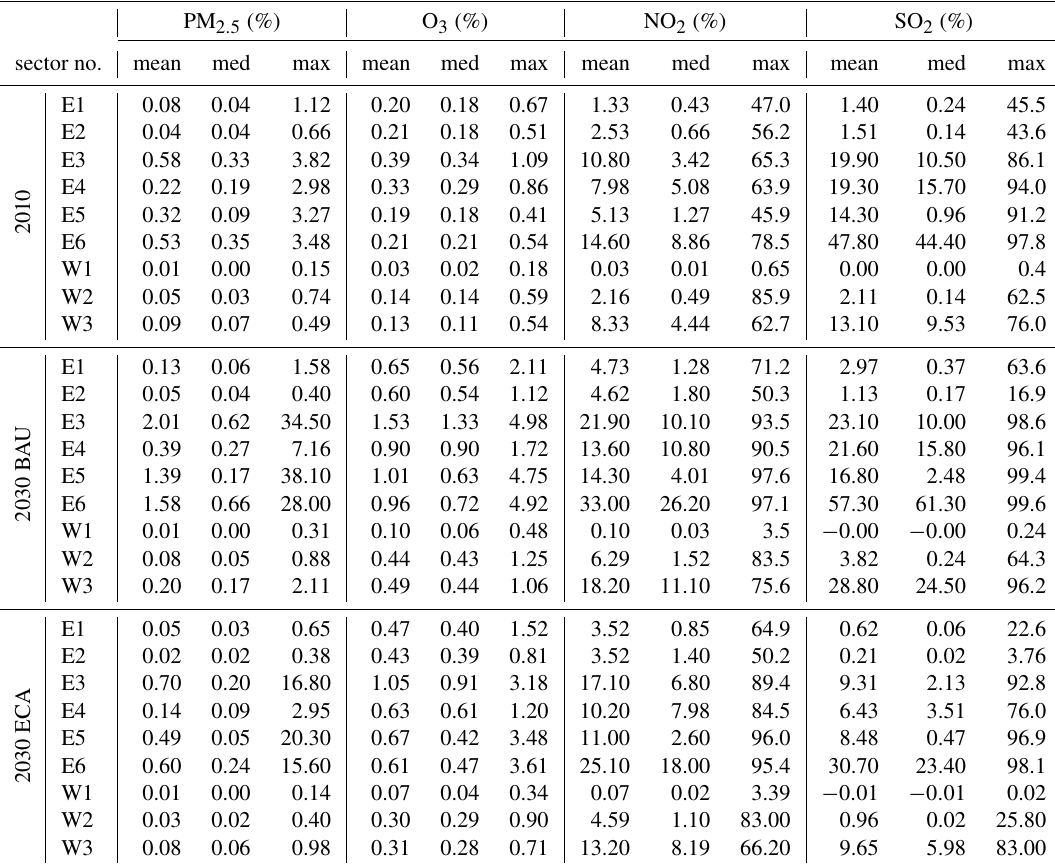
Table 6. Percentage contribution from Arctic shipping to ambient concentrations of criteria pollutants, by geographical sectors (see Table 1), for the July–August–September period. PM 2 . 5 (%) O 3 (%) NO 2 (%) SO 2 (%) sector